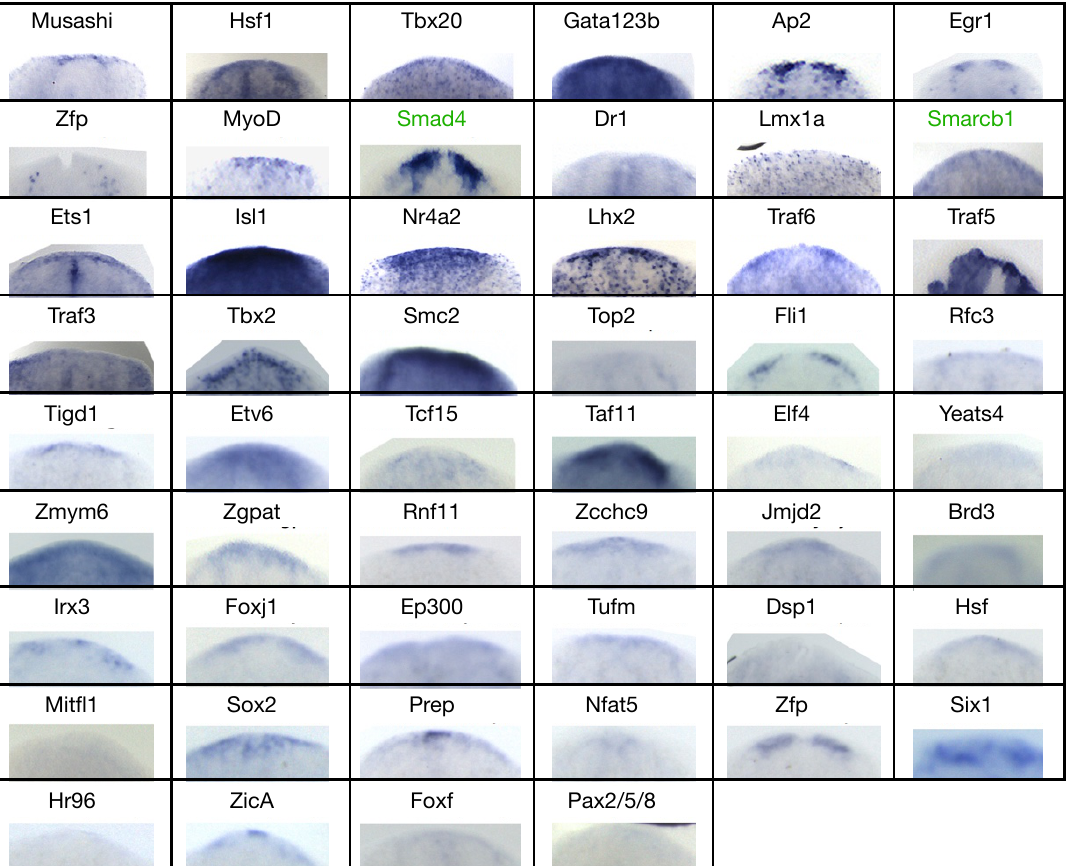
Figure 6s. Expression of the shortlisted blastema transcription factors in day 3 blastema, as for WISH. Transcription factors expressed in the anterior blastema of tail fragments after 3 days of regeneration, except for Zmym6, which is shown in the anterior blastema of a trunk fragment. In green, two genes that are not transcription factors but have some transcriptional regulation activity (Smad4 and Smarcb1). Scale bar: … …